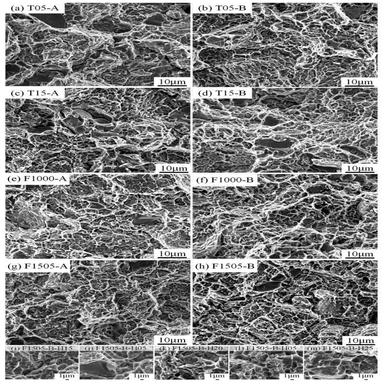
Fracture morphology of TiB2/Al7050 FGM: (a) T05-A; (b) T05-B; (c) T15-A; (d) T15-B; (e) F1000-A; (f) F1000-B; (g) F1505–A; (h) F1505–B; Enlarged microstructure of each layer of F1505-B: (i) F1505-B-H15; (j) F1505- B-H05; (k) F1505-B-H20; (l) F1505-B-H05; (m) F1505-B-H25.